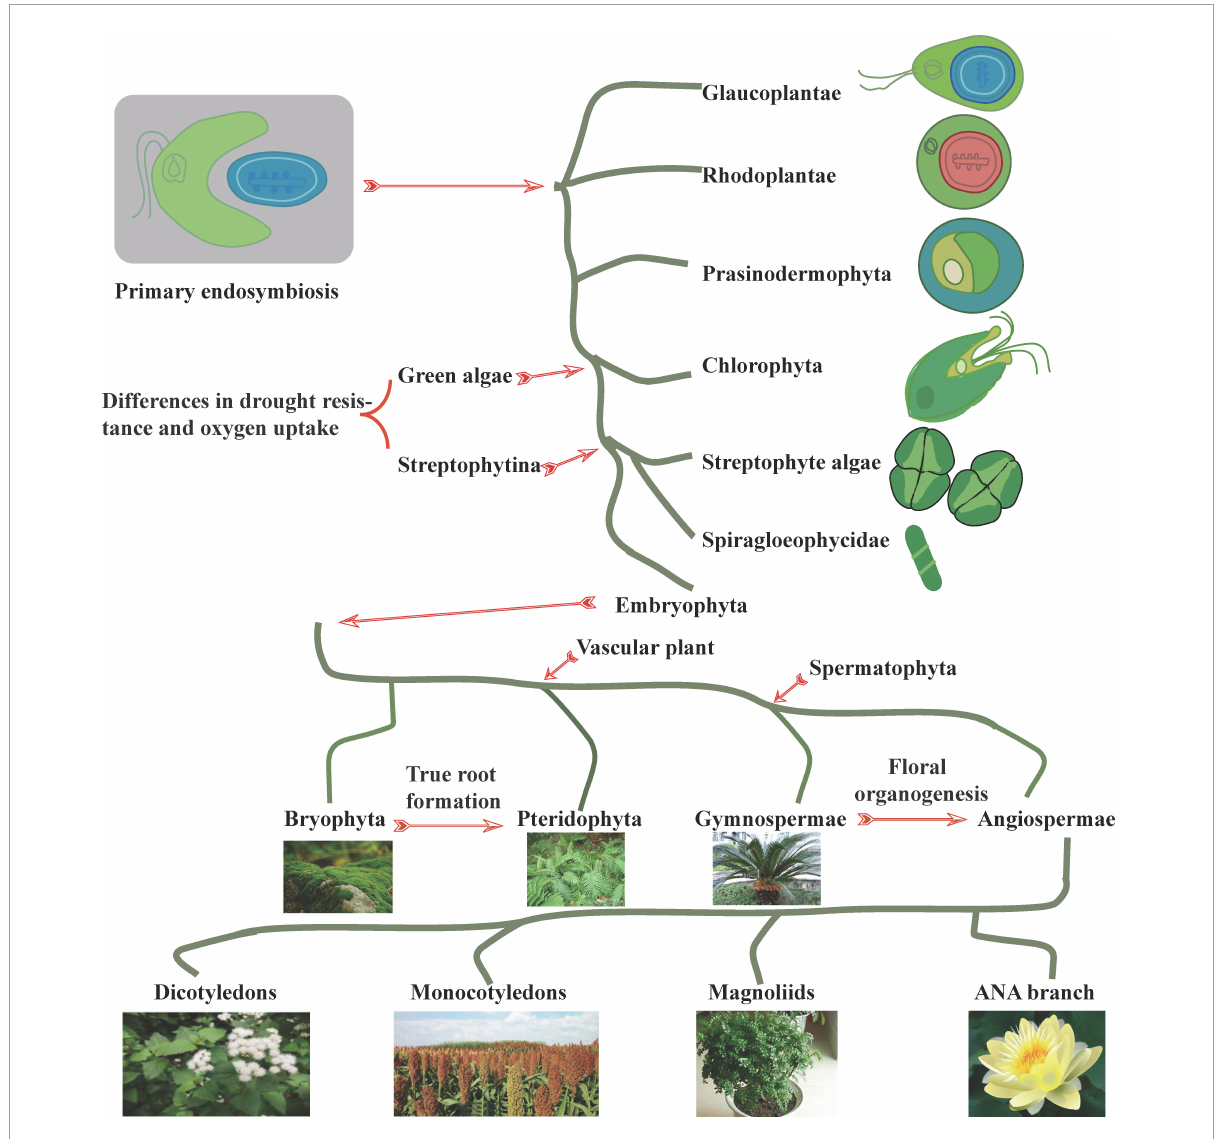
FIGURE1 Plant evolution. The symbiosis of dinoflagellate protists with cyanobacteria prompted the occurrence of phytoplanktonic communities, with diverse phytoplanktonic taxa (including plants, green algae, red algae, and cryptophytes) arising through biological adaptation to the environment. At the origin of green algae and Streptophytina, significant differences in drought and oxygen stress tolerance developed to facilitate terrestrialization. During the process of adaptation to the environment, certain taxa underwent unique adaptations in root, flower, and other related phenotypes, which in turn ensured the dominance of the widely distributed